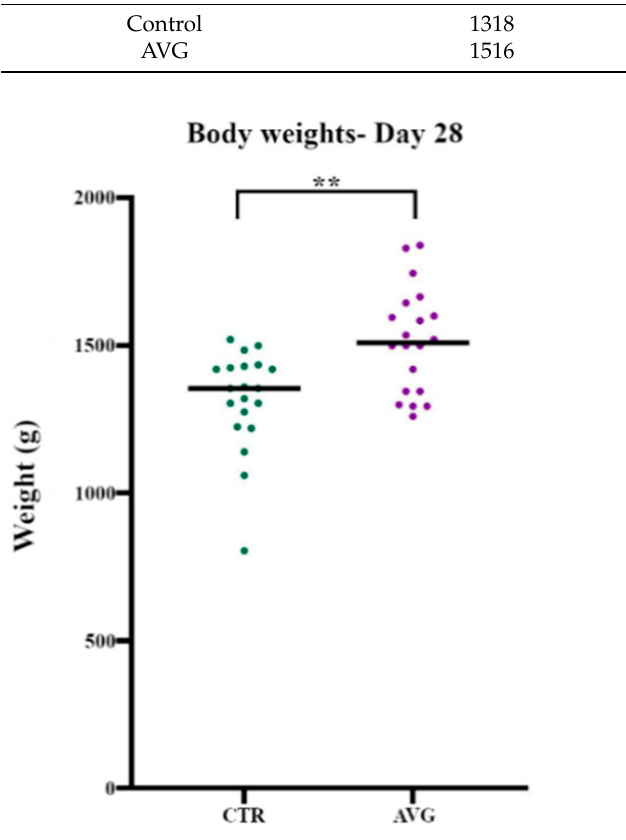
Figure 1. Body weights of birds on day 28 (Sample collection day). ** represent p = 0.0026.